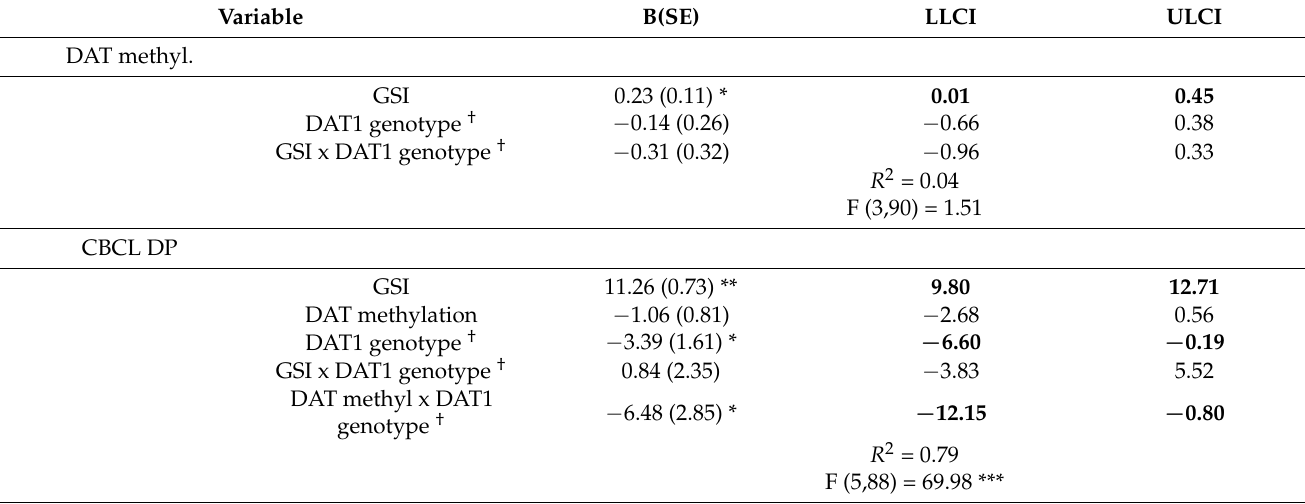
Table 3. Results of moderated mediation analyses.